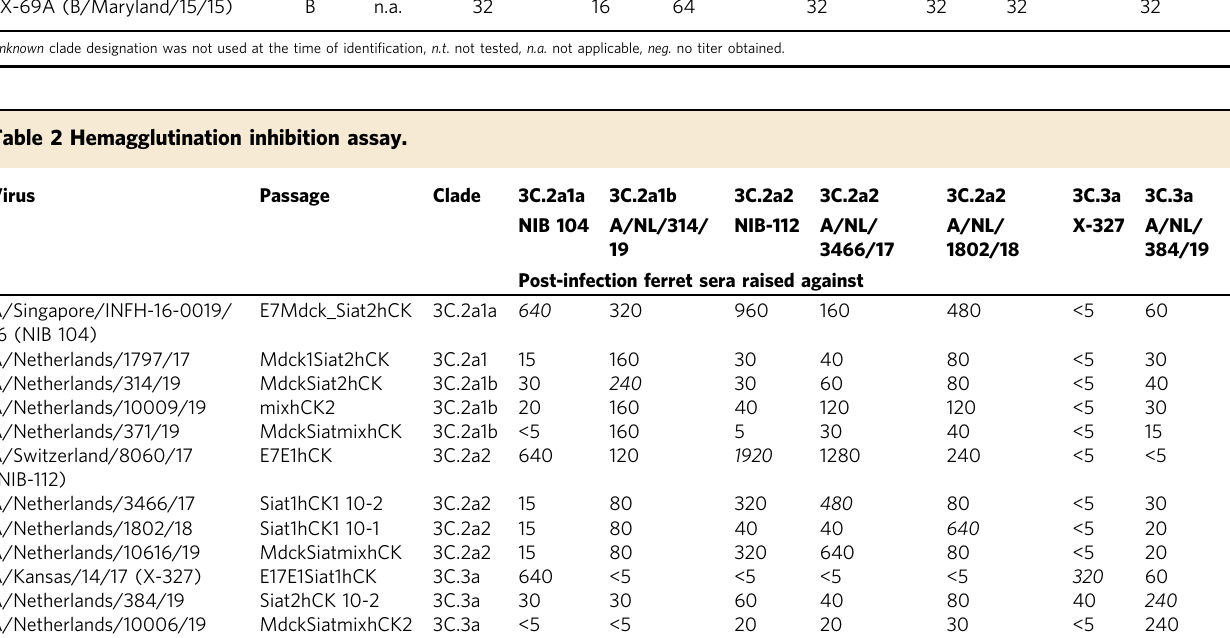
Italic values indicate homologous titers/antiserum